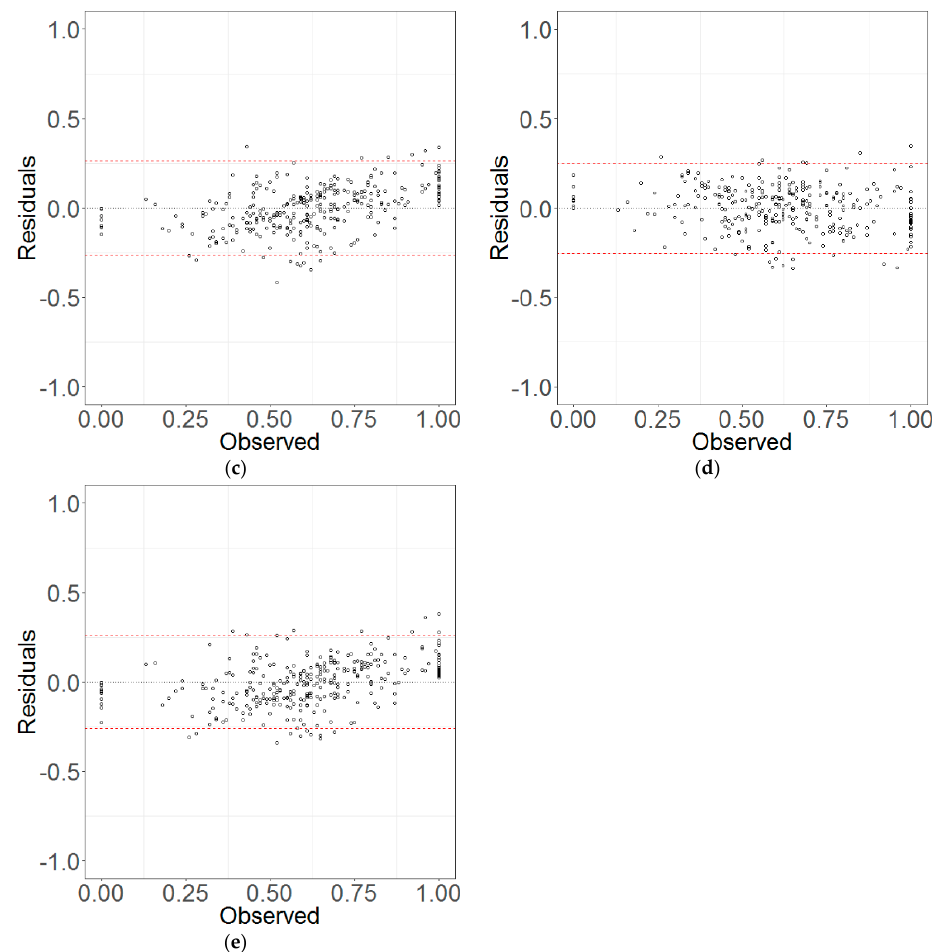
Figure 12. The residuals of percentage vegetation cover predictions graphed against the observations or referenced values for Duolun County using: ( a ) Linear stepwise regression (LSR); ( b ) Geographically weighted regression (GWR); ( c ) Constant kNN (Cons_kNN) with 11 nearest plots; ( d ) Optimized kNN (Opt_kNN); and ( e ) Random forest (RF). The red dashed lines represented the confidence interval of zone residuals at the significant level of 0.05.